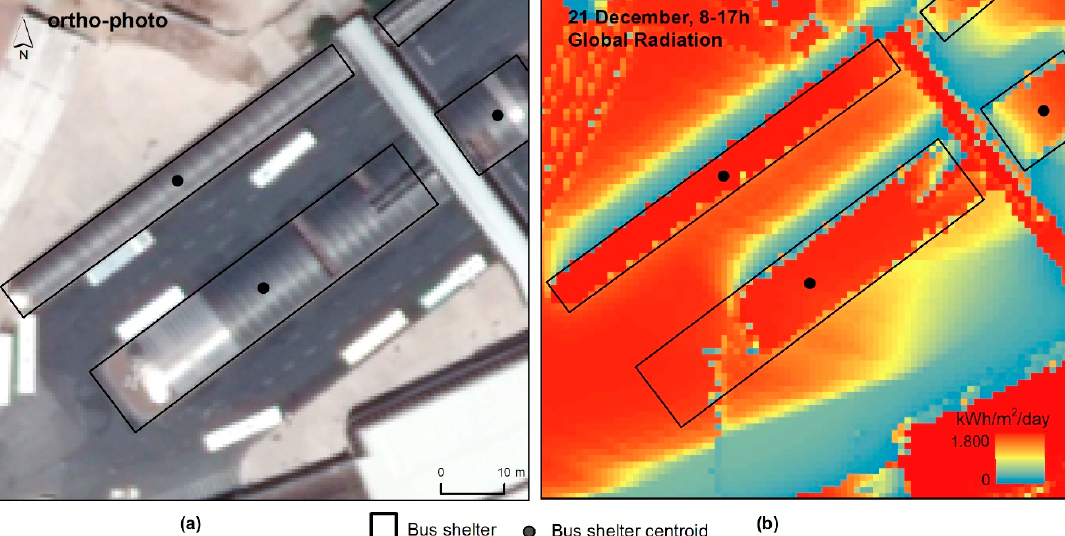
Figure 6. Misalignment between the bus shelter ( a ) and the solar map ( b ).